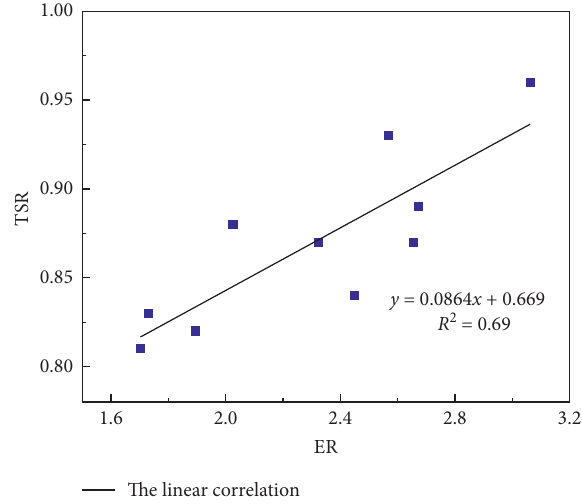
Figure 12: Relationship between TSR and ER values.